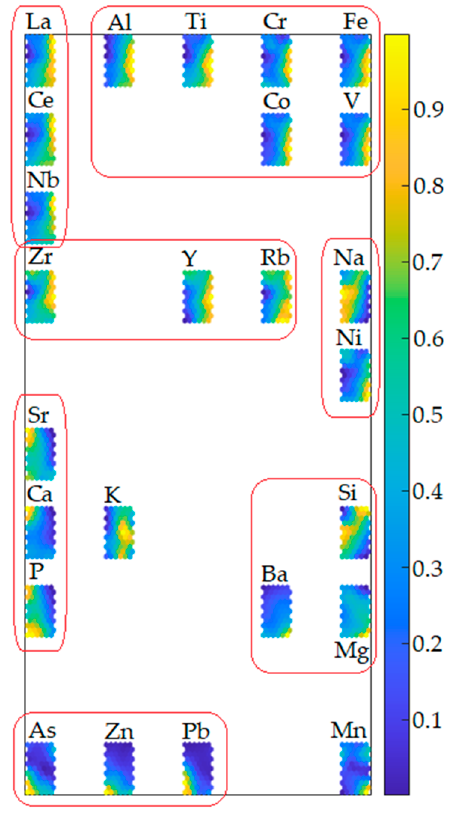
Figure 3. Soil quality parameter similarity pattern obtained by self-organizing mapping. An analysis of the distance between variables on the map connected with an assessment of the colour-tone patterns provides semi-quantitative information about the nature of correlations between them.